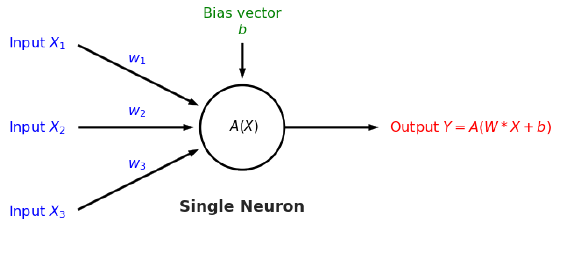
Figure A4. Visualization of the operation y = A ( WX + b ) in a single ANN node. The weighted sum of its inputs is added to a bias term; the final sum is transformed by a nonlinear activation function chosen by the